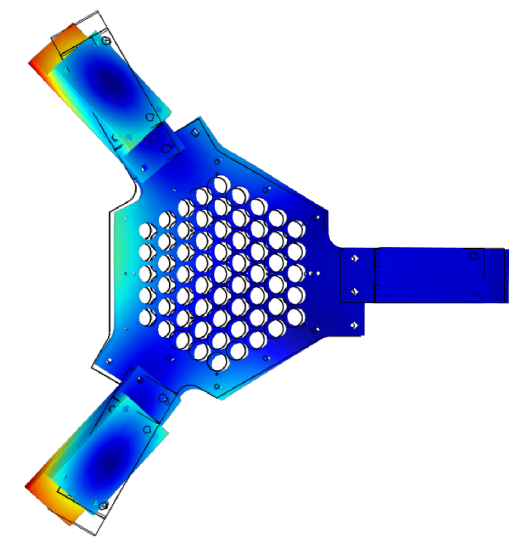
Figure 8. Flapping modeshape of the actuators at 1080 Hz (measured) [14]. To increase the bandwidth of the system, Jansen redesigned the actuator in